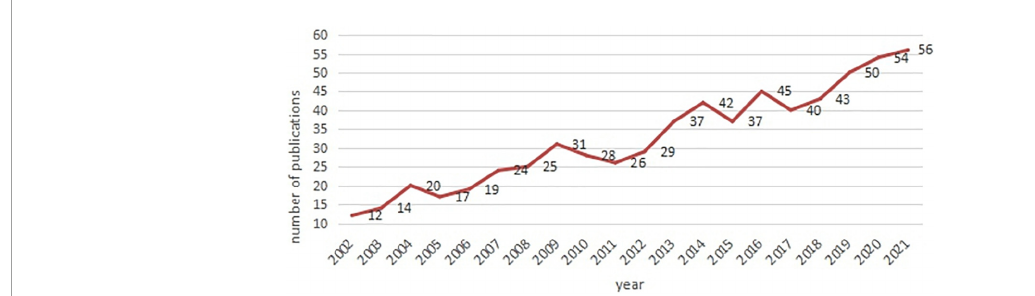
FIGURE2 Trend of numbers of publications on AR in children by years.